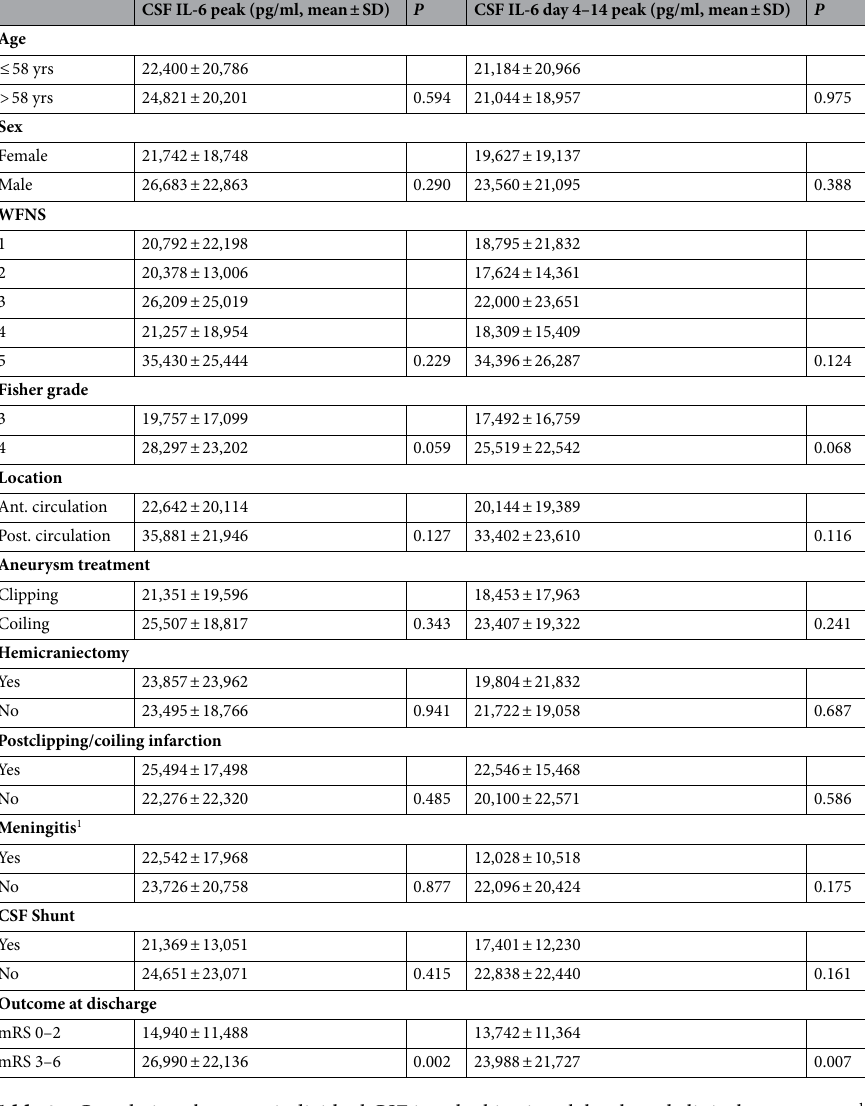
Table 3. Correlations between individual CSF interleukin-6 peak levels and clinical parameters. 1 Culture-